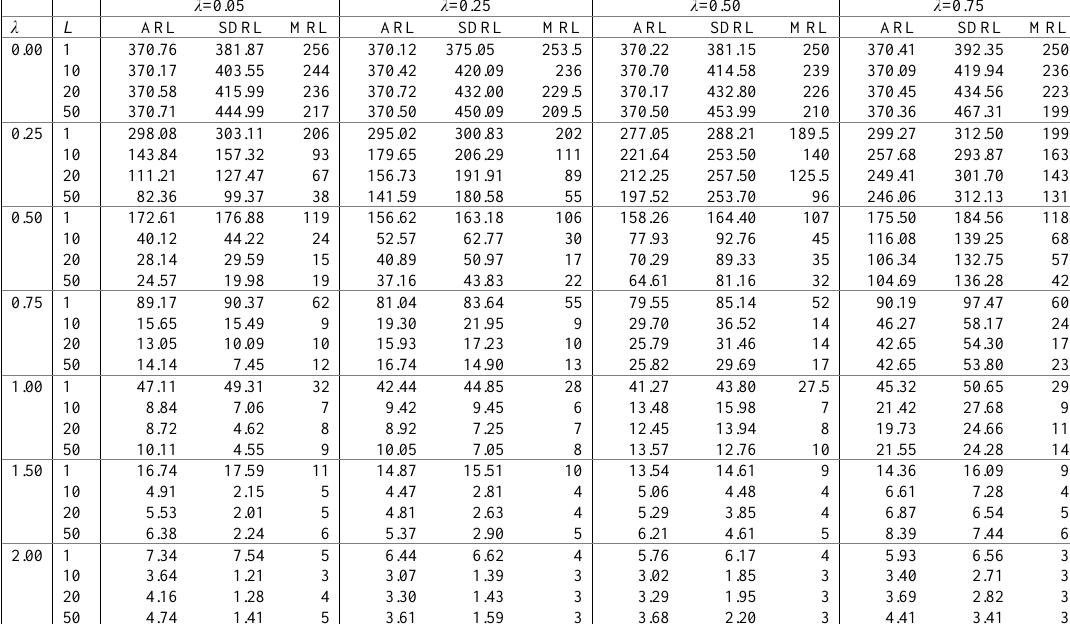
Table 3. ARLs, SDRLs, and MRLs for the proposed control chart when λ ={0.05, 0.25, 0.50, 0.75}, and L =1, 10, 20,